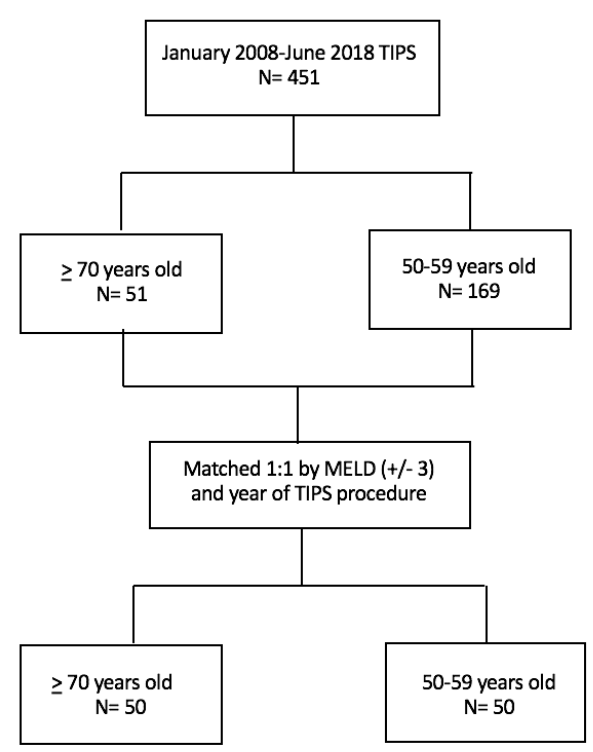
Figure 1. Patient Figure 1. Patient selection.